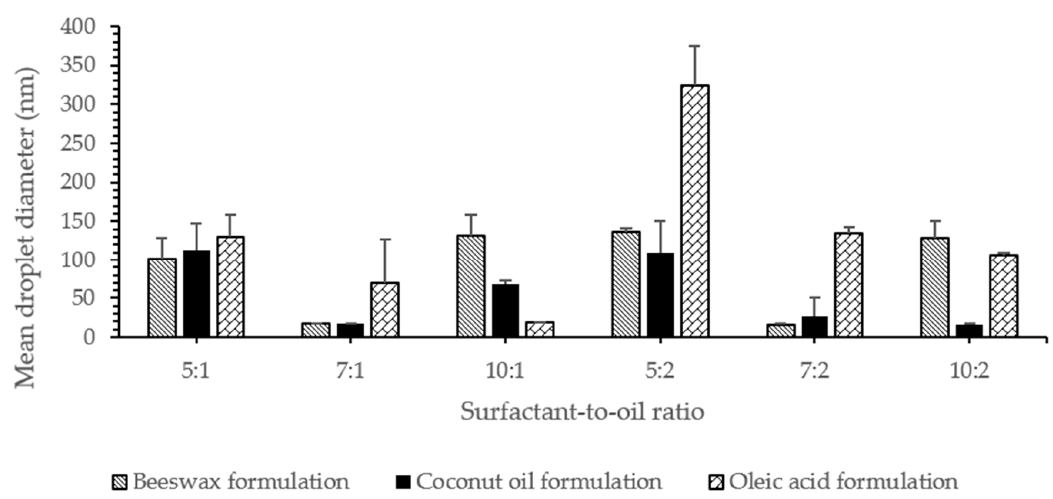
Figure 4. The e ff ect of surfactant concentration on the droplet size of Figure 4. The effect of surfactant concentration on the droplet size of NEs.